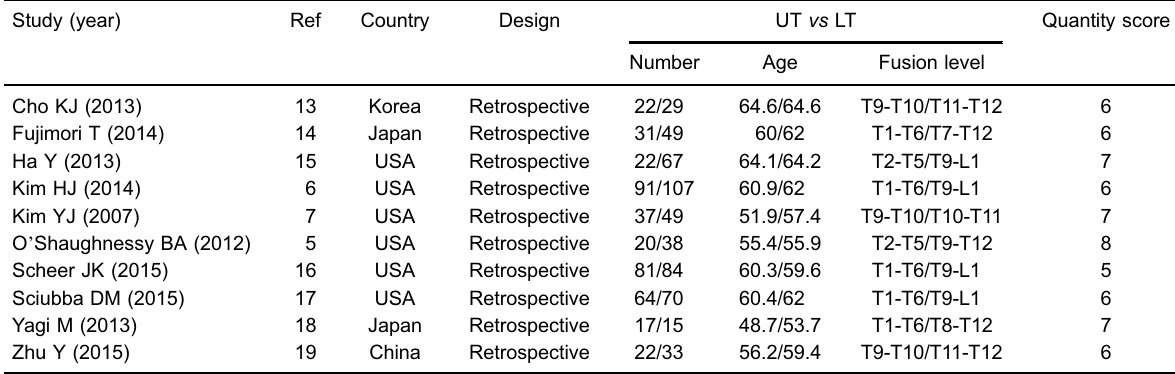
Figure 1. Literature search and study selection. Table 1. Characteristics of included studies on posterior long-segment fi xation for degenerative lumbar